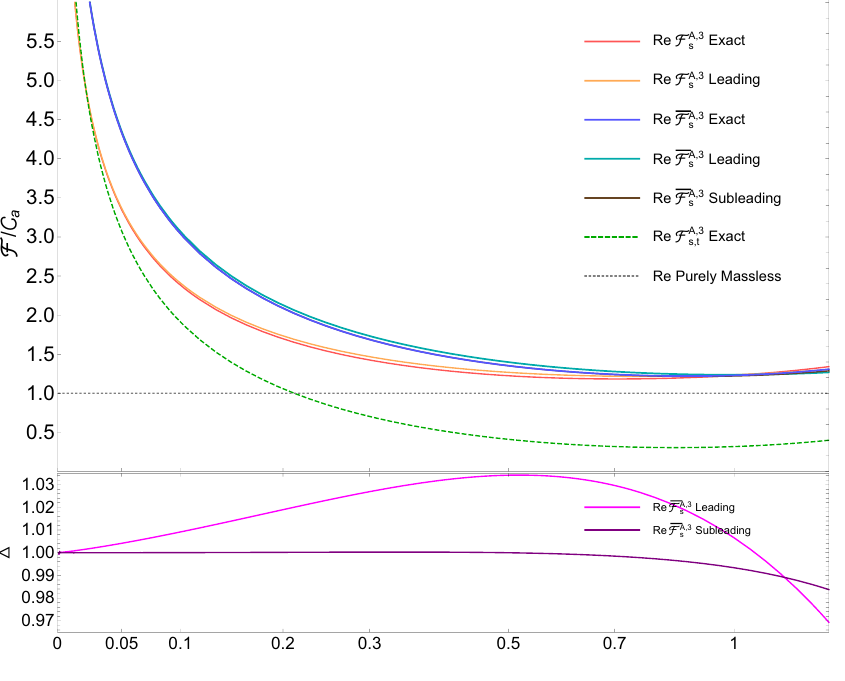
Figure 5 . Comparison of the real part of the exact result for ¯ F A, 3 ( x ) defined in eq. (5.2) with its s leading and subleading large mass approximation, as function of x = s/m 2 in the range (0 , 1 . 33) . t The FFs are normalized w.r.t. the real part of the 5-flavor massless result C a ≈ 175 . 218 [42]. The curves representing the exact result for F A, 3 ( x ) introduced below eq. (4.12) and its leading large- s mass approximation are included for reference. The lower panel shows the ratios of the leading and subleading approximation to the exact result. A similar plot for the imaginary part is given in figure